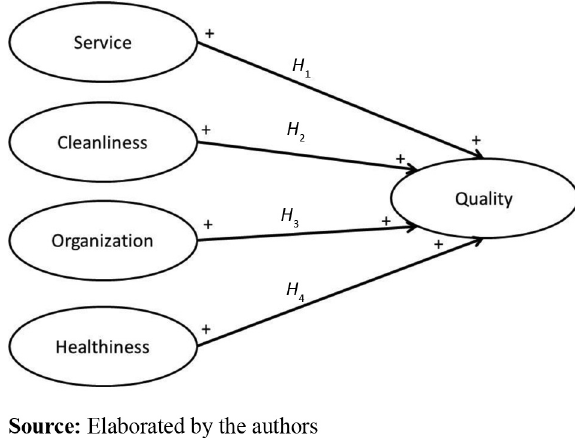
Figure 1. Initial